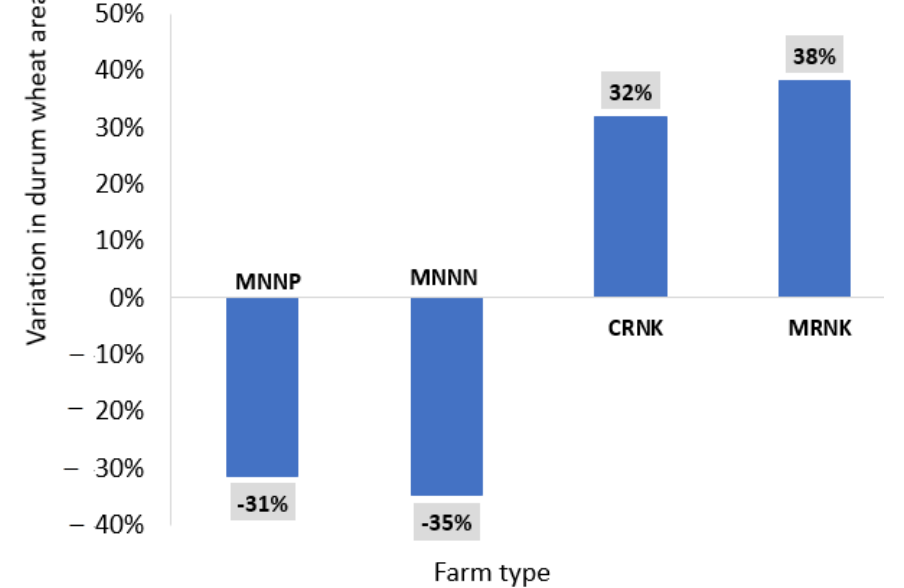
Figure 5. Variation in durum wheat area by farm type as a function of (S1).